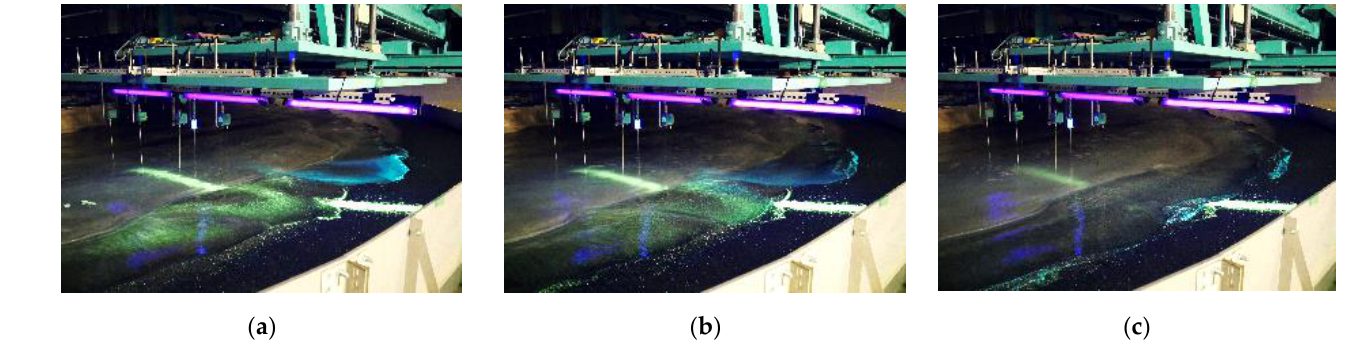
Figure 15. Snapshots of fluorescent sands movement during the experiment in Case 4a: ( a ) after 1 min ( b ) after 5 min ( c ) after 60 min. 1 min ( b ) after 5 min ( c ) after 60